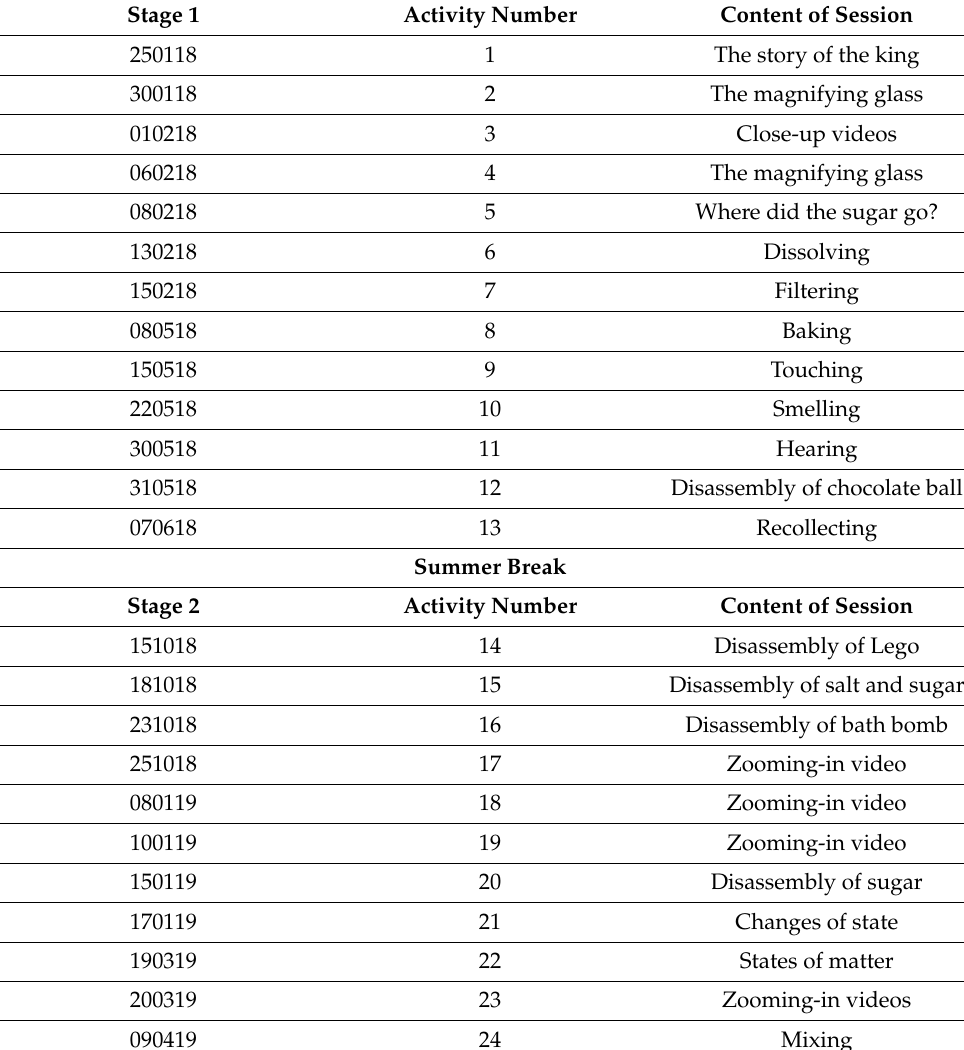
Table 1. A summary and timeline of the activities included into the